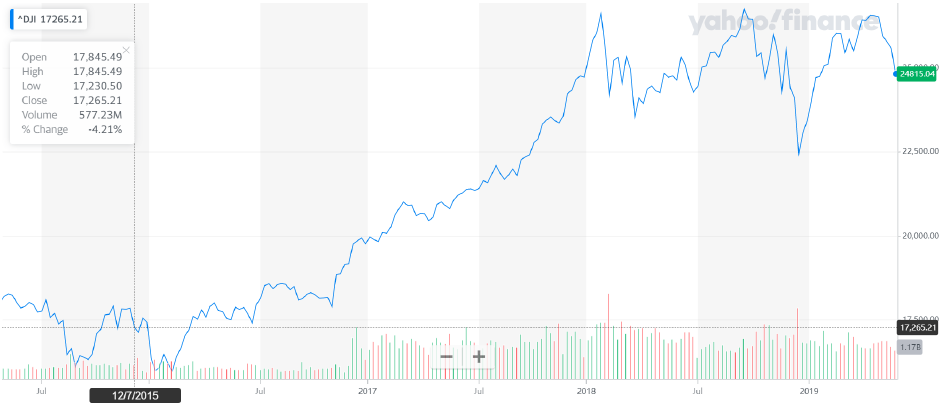
Fig. 2 SSE 300 Financial Daily Yield (January 2015 to June 2019)